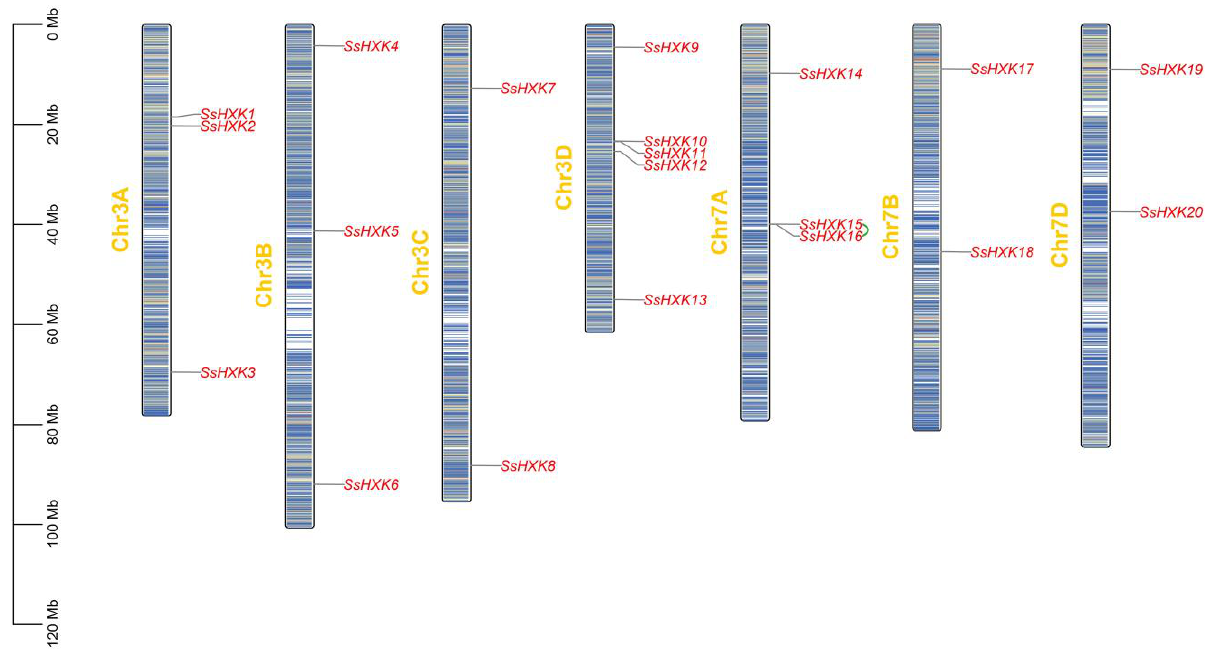
Figure 1. The chromosomal distribution of SsHXKs . The green line between the two gene names represented that they were tandem gene pair. Scale bar on the left indicates the chromosome lengths (Mb).